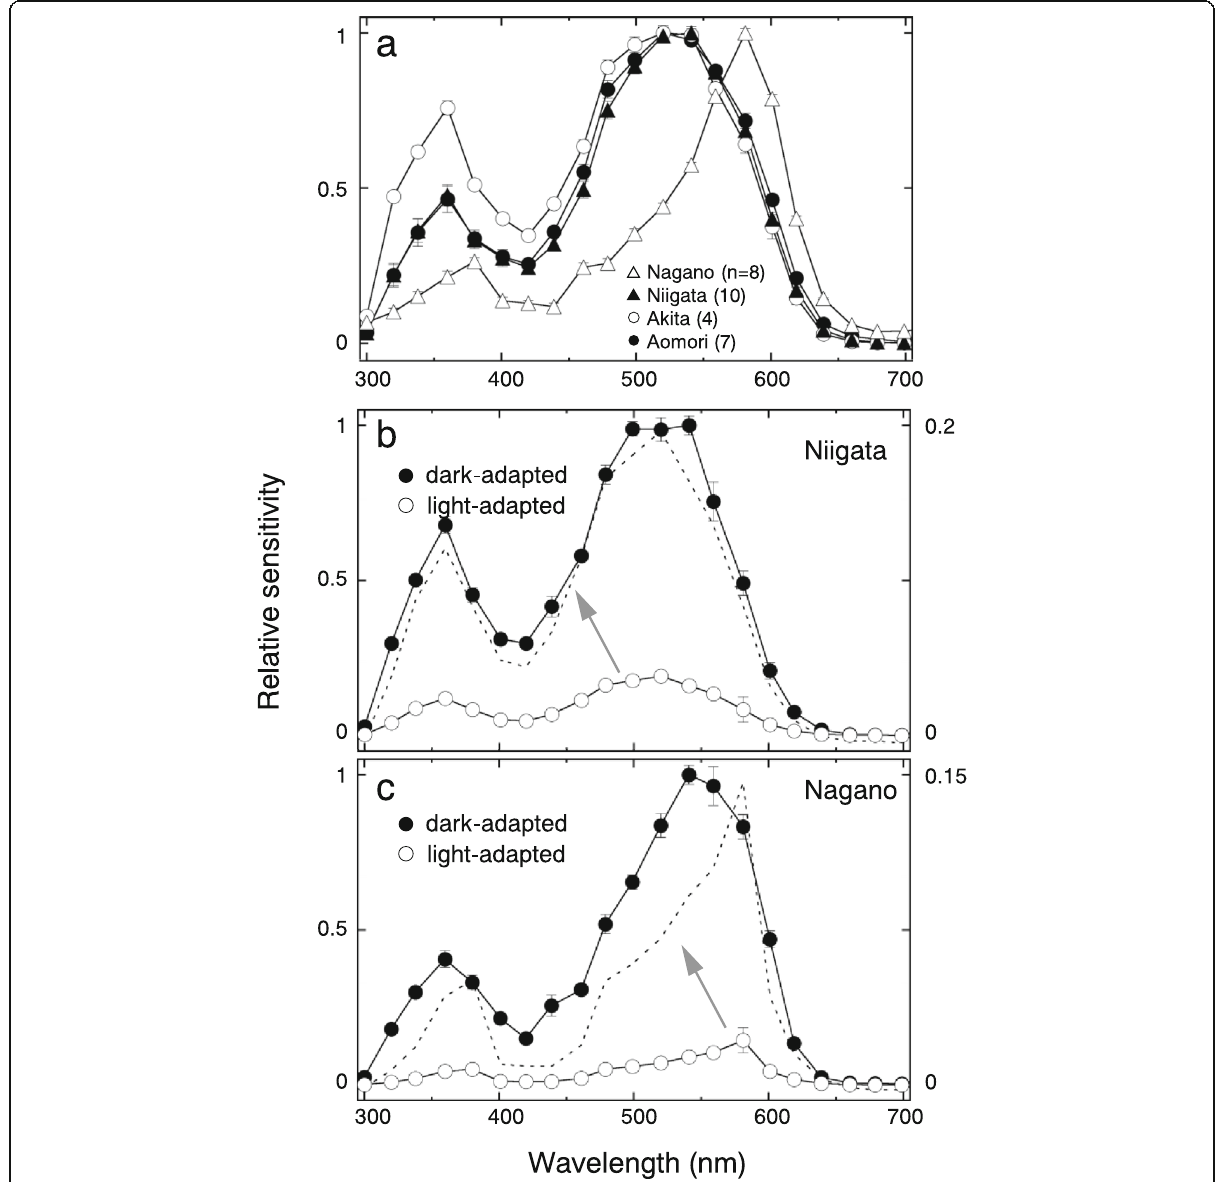
Fig. 4 ERG-determined compound eye spectral sensitivities of male Adoxophyes orana . a Averaged light-adapted spectral sensitivities of individ- uals from Nagano ( n = 8), Niigata (10), Akita (4) and Aomori (7) strains. b Dark- and light-adapted spectra recorded from the same Niigata individ- uals ( n = 2), to measure the change in absolute sensitivity in the light-adapted state. The dotted spectrum shows the light-adapted spectrum expanded vertically (scale on the right). c Same as b , for the Nagano strain ( n = 1) Table 2 Calculated normalization and pigment contribution factors are shown in Fig. 5. The model fitting well explained Strain State c k both the light-adapted Niigata spectrum (Fig. 5a, red) and the dark-adapted Nagano spectrum (Fig. 5b, blue). The model deviates somewhat from the light- adapted Nagano spectrum (Fig. 5b, open circles), but the fit appears more reasonable when compared with the averaged spectral sensitivity (half-filled squares, same spectrum shown in Fig. 4a), suggesting that the